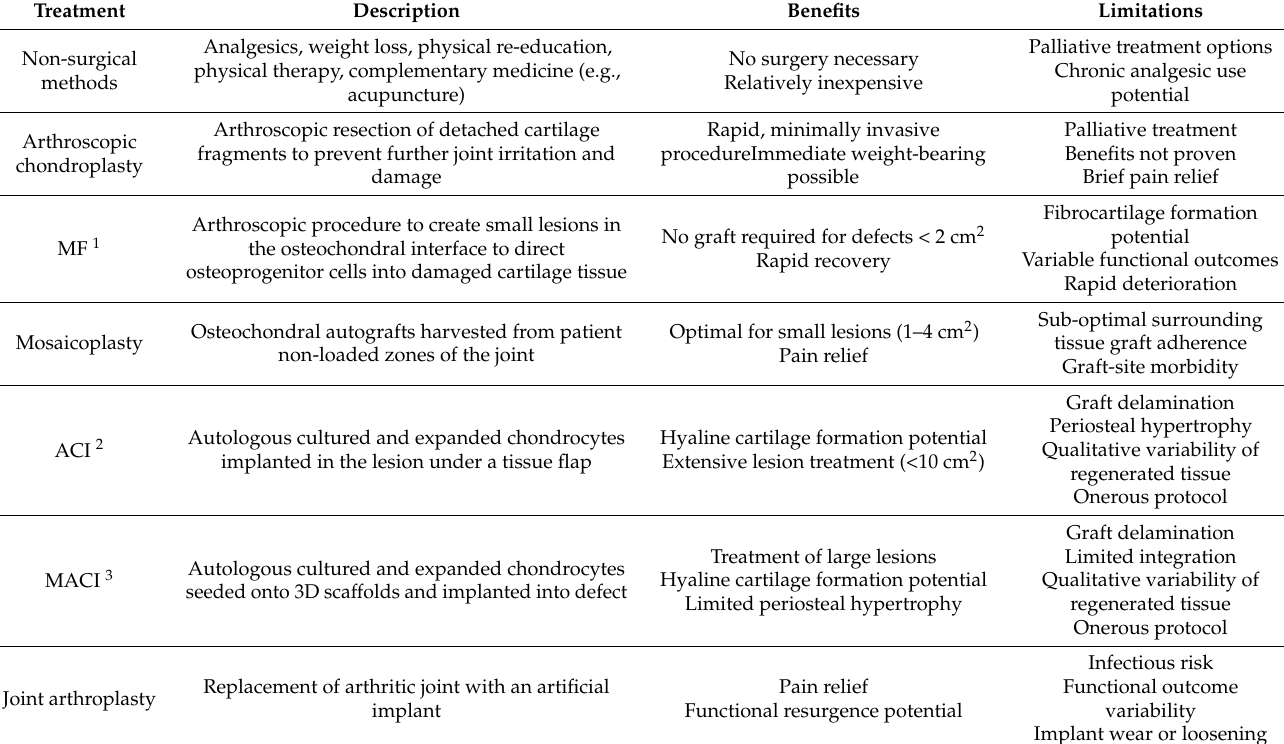
Table 1. Clinically available options for chondral injury